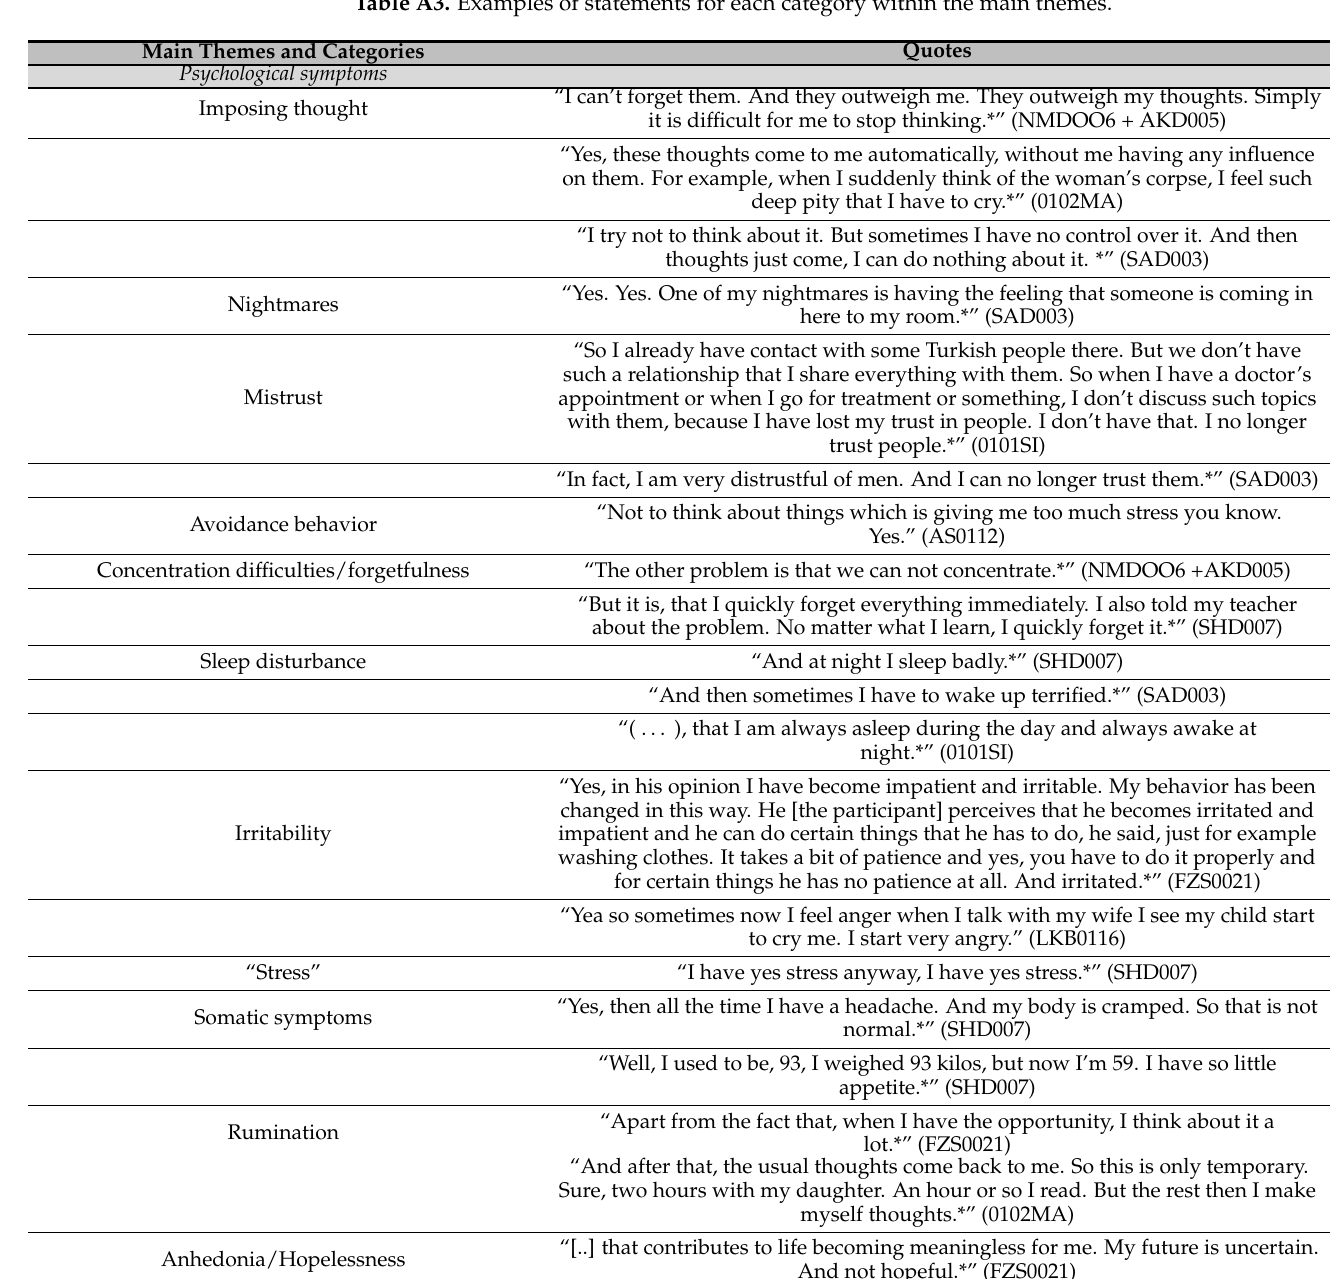
Table A3. Examples of statements for each category within the main